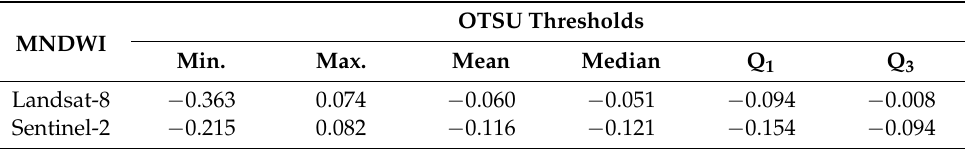
Table 5. OTSU thresholds statistics.